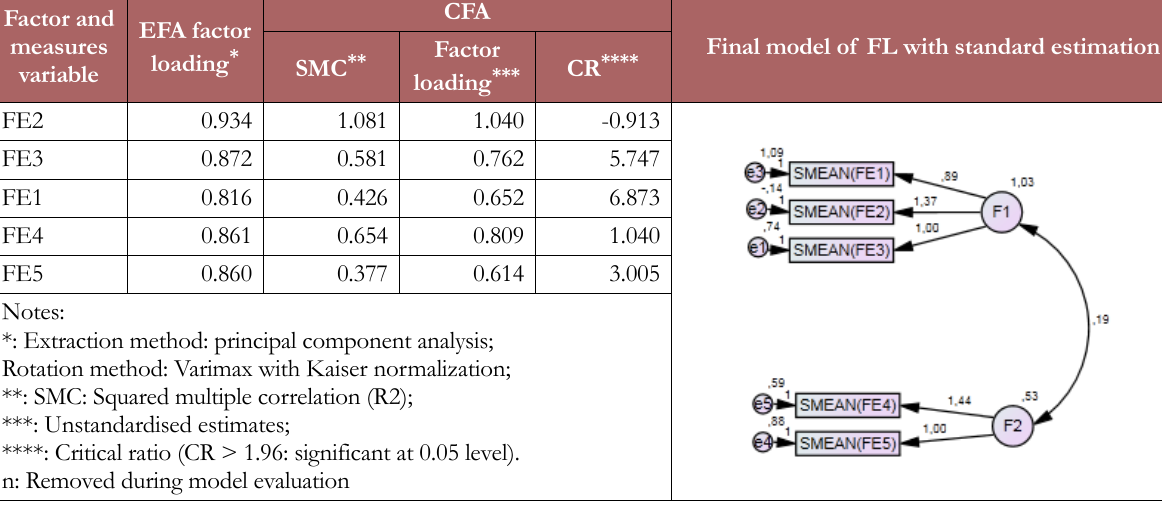
Table 19. EFA and CFA of the FE